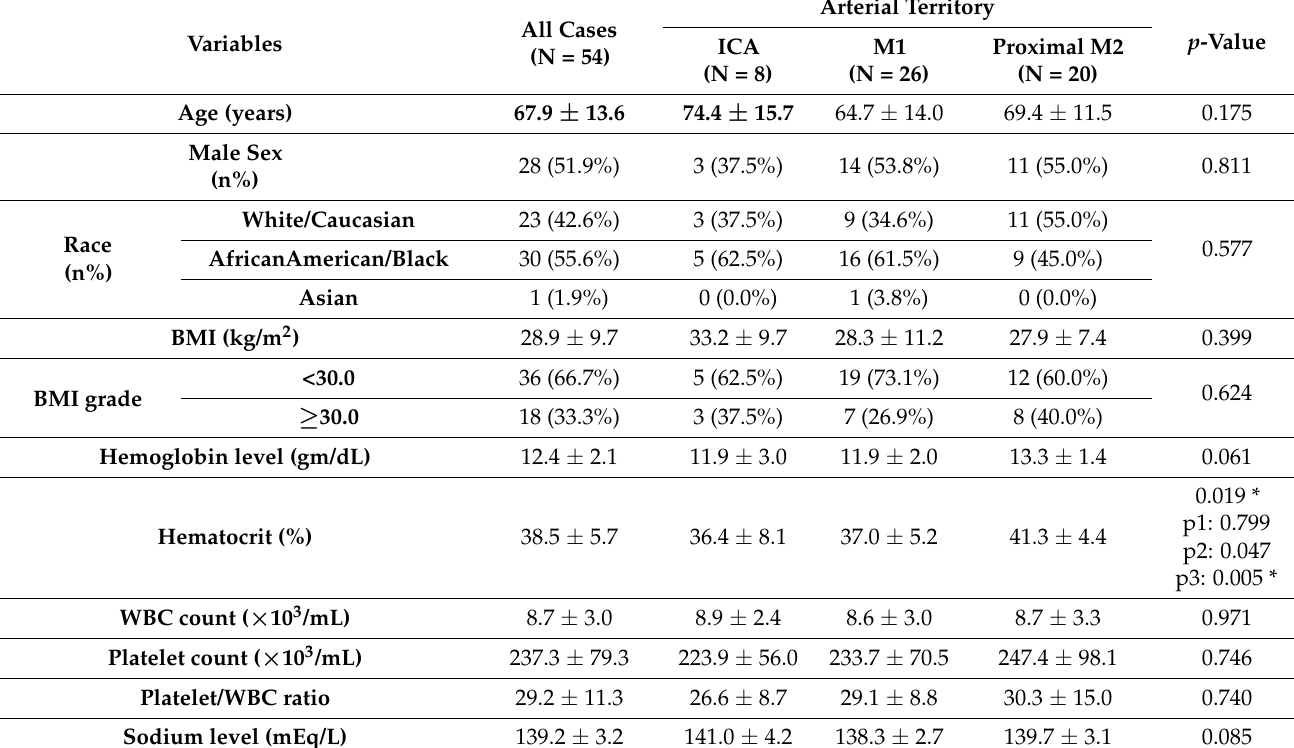
Table 1. Baseline demographics of the study population and their comparison based on the affected arterial